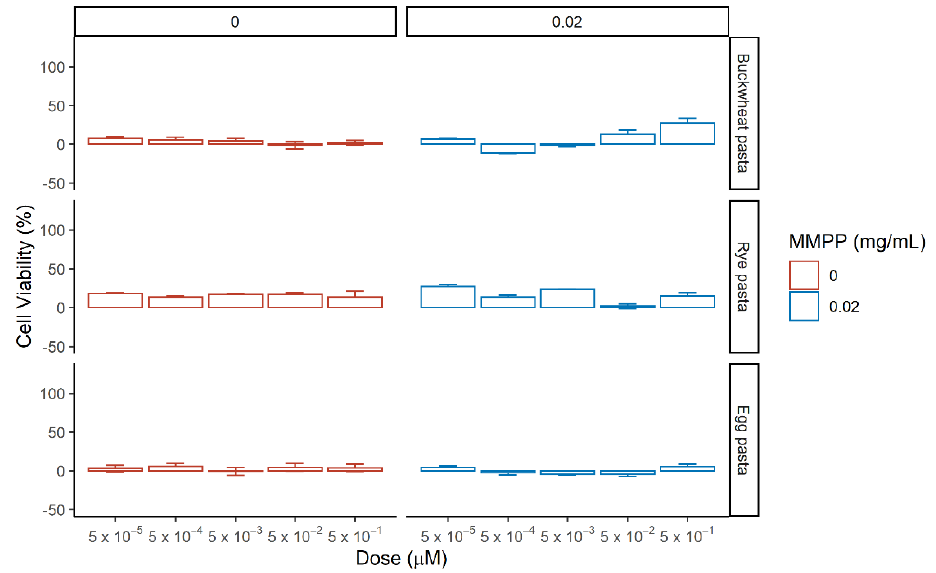
Figure 8. Effect of the pasta-derived hydroalcoholic extracts on the cell viability of HEK-293 in the absence (left, red) or presence (right, blue) of MMPP after 72 h incubation. Reported values correspond to mean of the difference in cell viability between tested phytocomplexes and reference (medium in red, and MMPP in blue) with standard error over three biological replicates. The percentage of cell viability was calculated using the ratio Abs TEST /Abs CTRL .